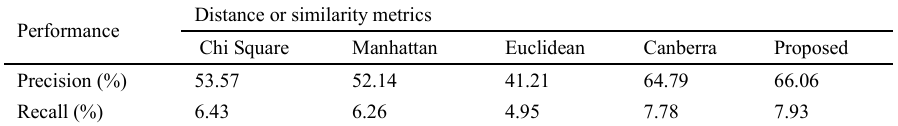
Table 6. Average retrieval precision and recall of different distance